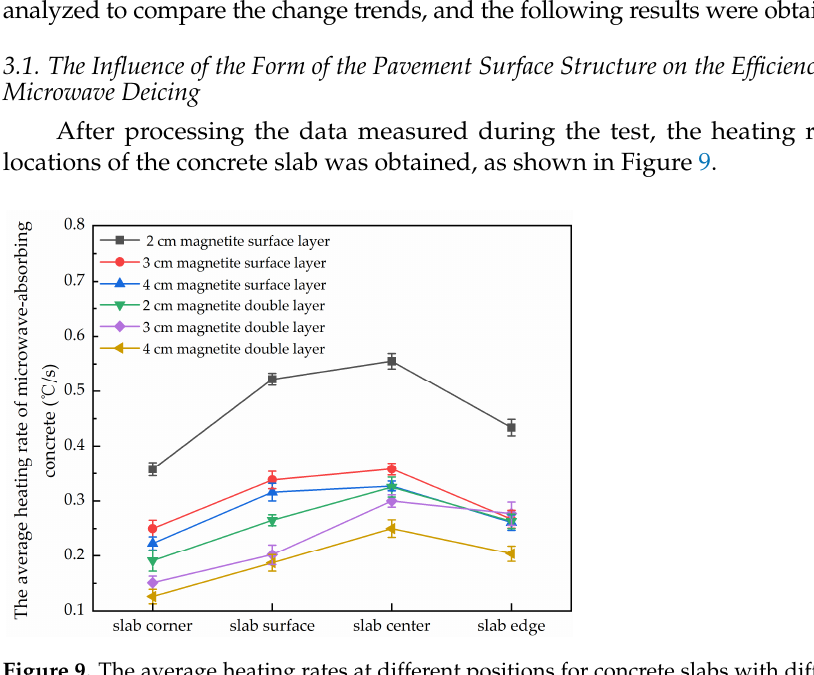
Figure 9. The average heating rates at different positions for concrete slabs with different microwave-absorbing materials (°C/s).